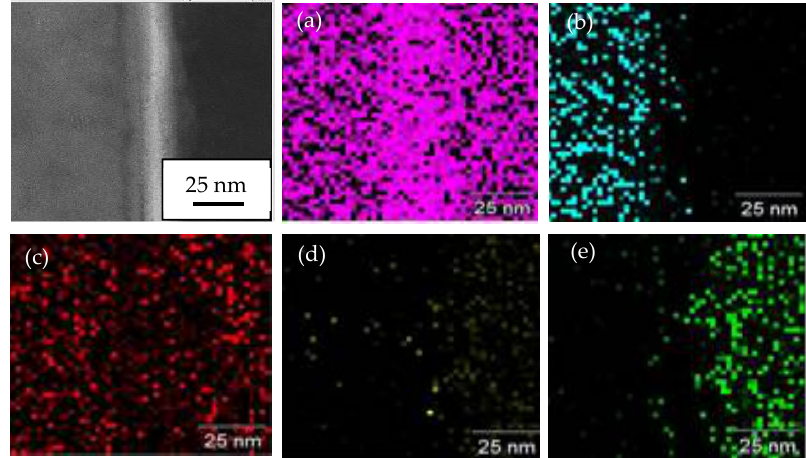
Figure 12. EDX elemental mappings at the TiO 2 / 1000 ◦ C annealed SUS 304 interface at the bonded region, B: ( a ) oxygen; ( b ) titanium; ( c ) nitrogen; ( d ) chromium; ( e )